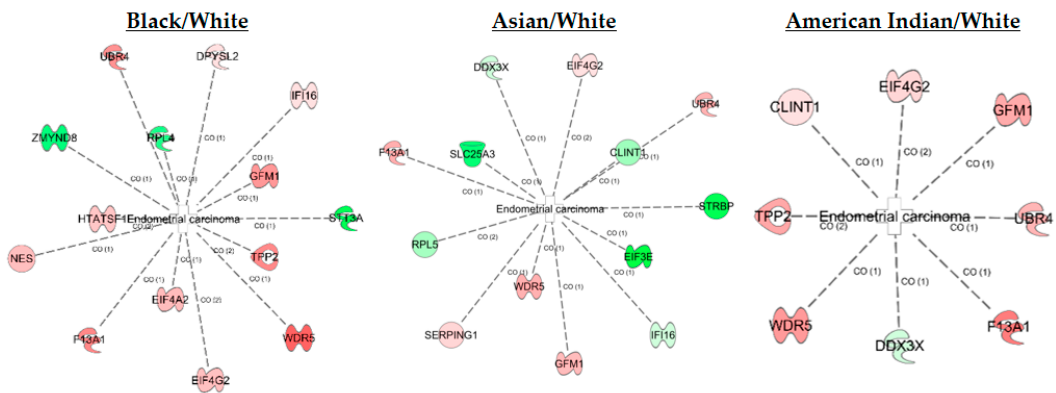
Figure 3. IPA-identified canonical pathways associated with 44 proteins present at significantly dif- ferent levels in endometrial cancer specimens from Black, African American or Asian compared to the White race. B: Black, AI: American Indian, A: Asian, W: White IPA analysis of the fold differences between these proteins in each non-White group compared to the White group documented their associations with endometrial cancer (Figure 4), which provides a certain level of validation to the results of this study.